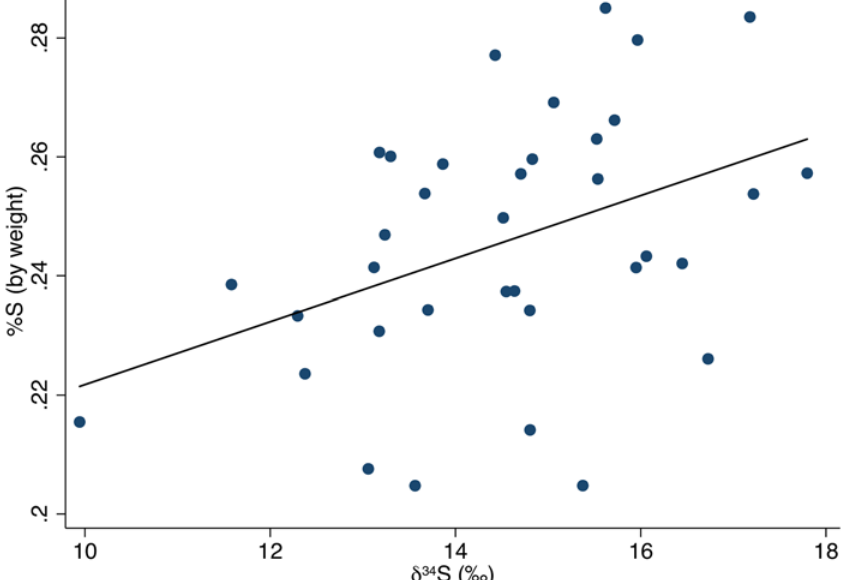
Fig 7. δ 34 S values and %S by weight with fitted regression line (y = 0.005x + 0.169, p = 0.028).